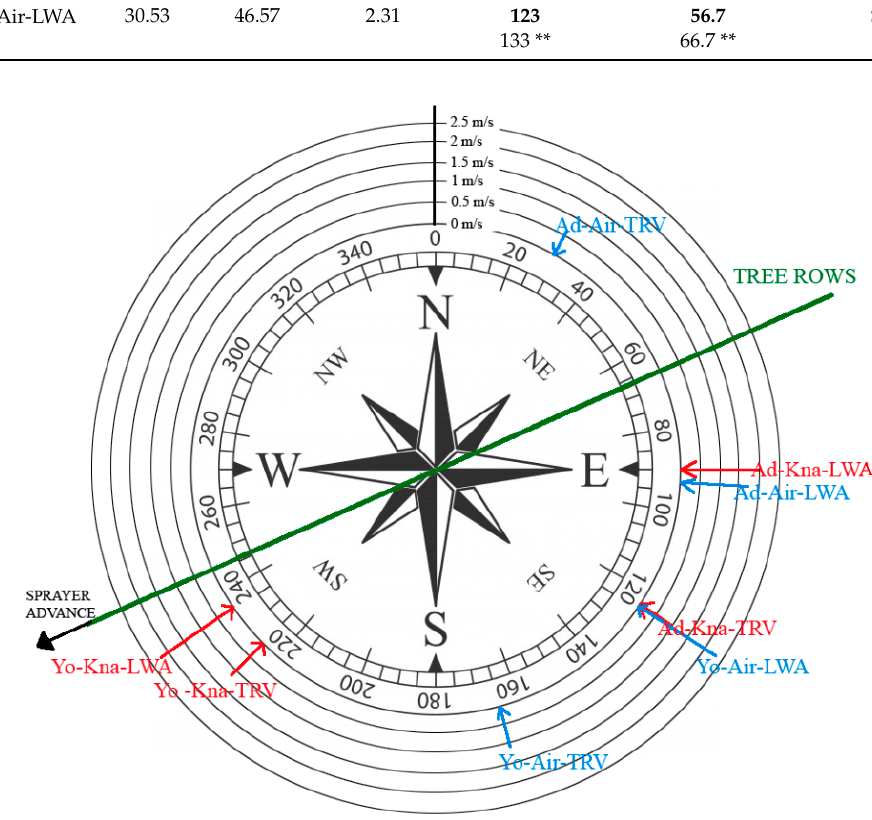
Figure 5. The treatments carried out with the knapsack are in red, and the treatments carried out with the air-blast sprayer are in